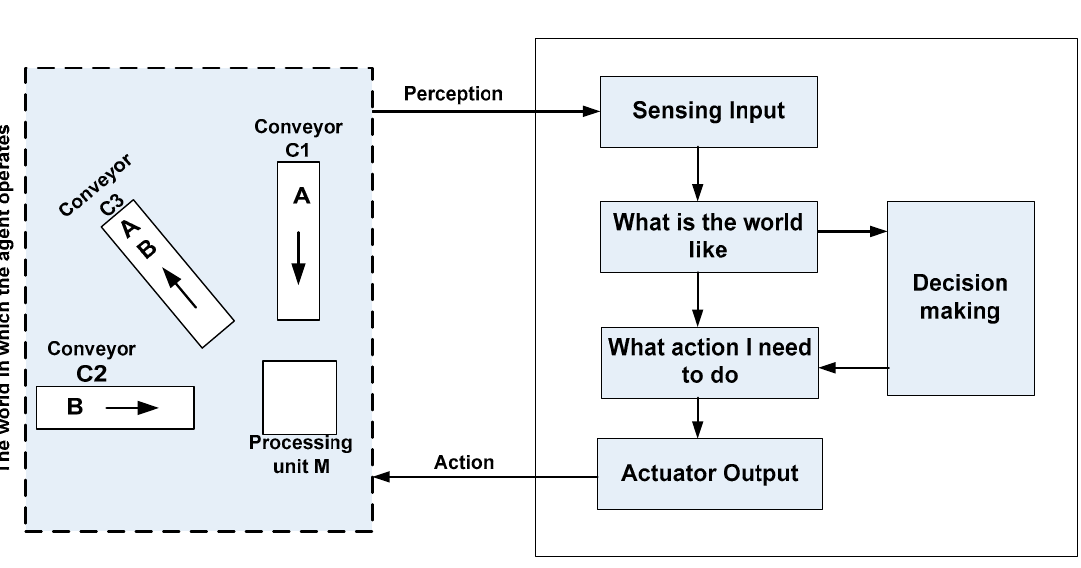
Figure 2. The conceptual planning model.